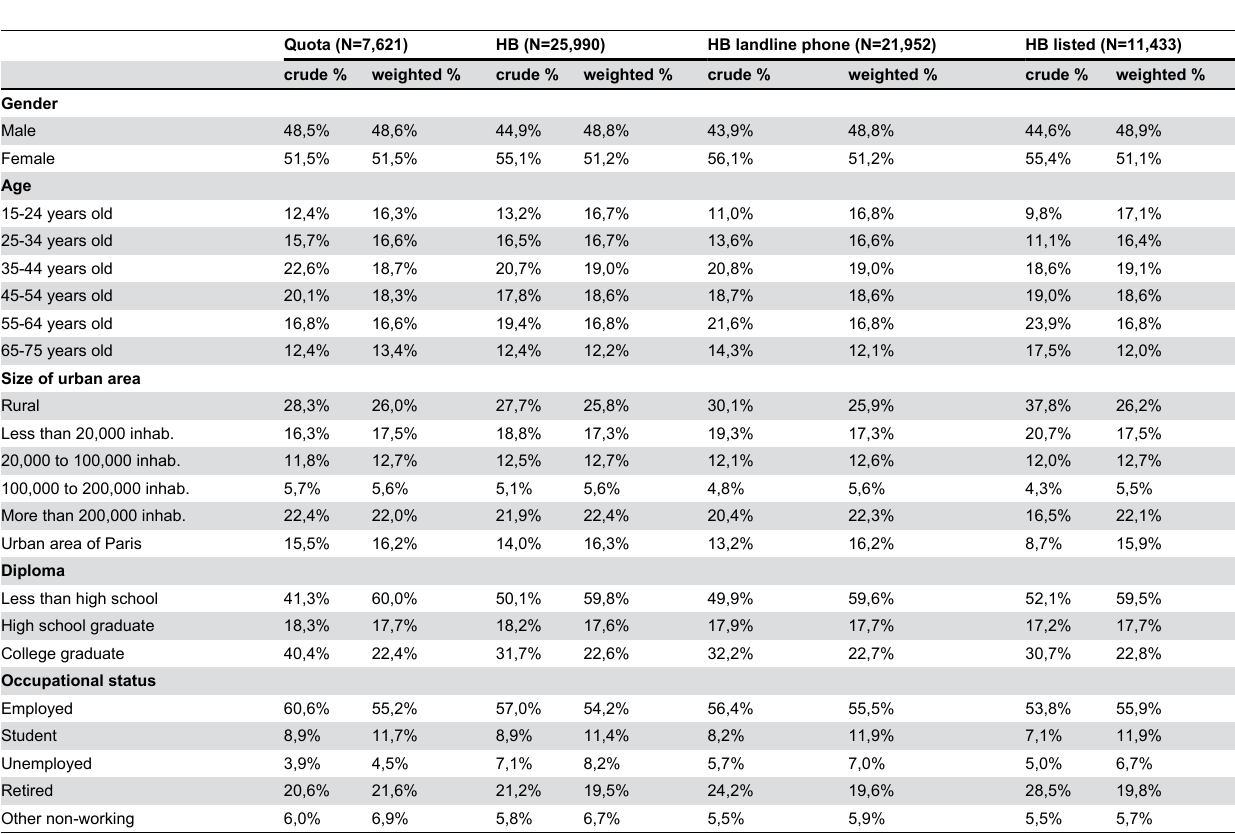
Table 1. Socioeconomic characteristics of the 15-75 years-old interviewed in the quota survey and in the Health Barometer (HB), in the whole, among landline phone owners and among listed respondents in the Health